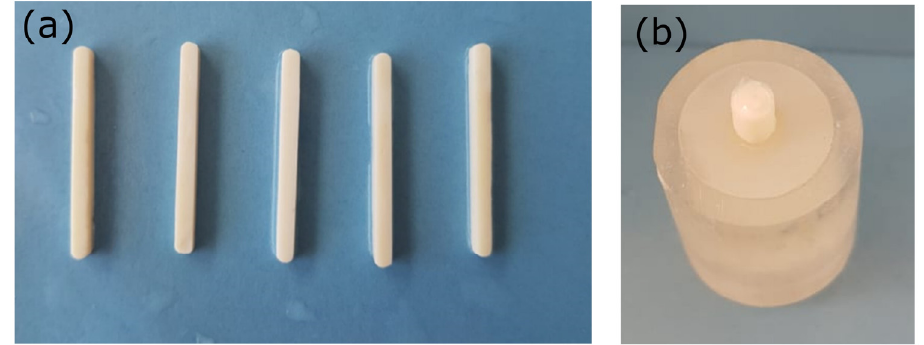
Figure 7. ( a ) Specimens prepared for flexural strength, ( b ) embedded zirconia specimens after cementation for shear bond strength